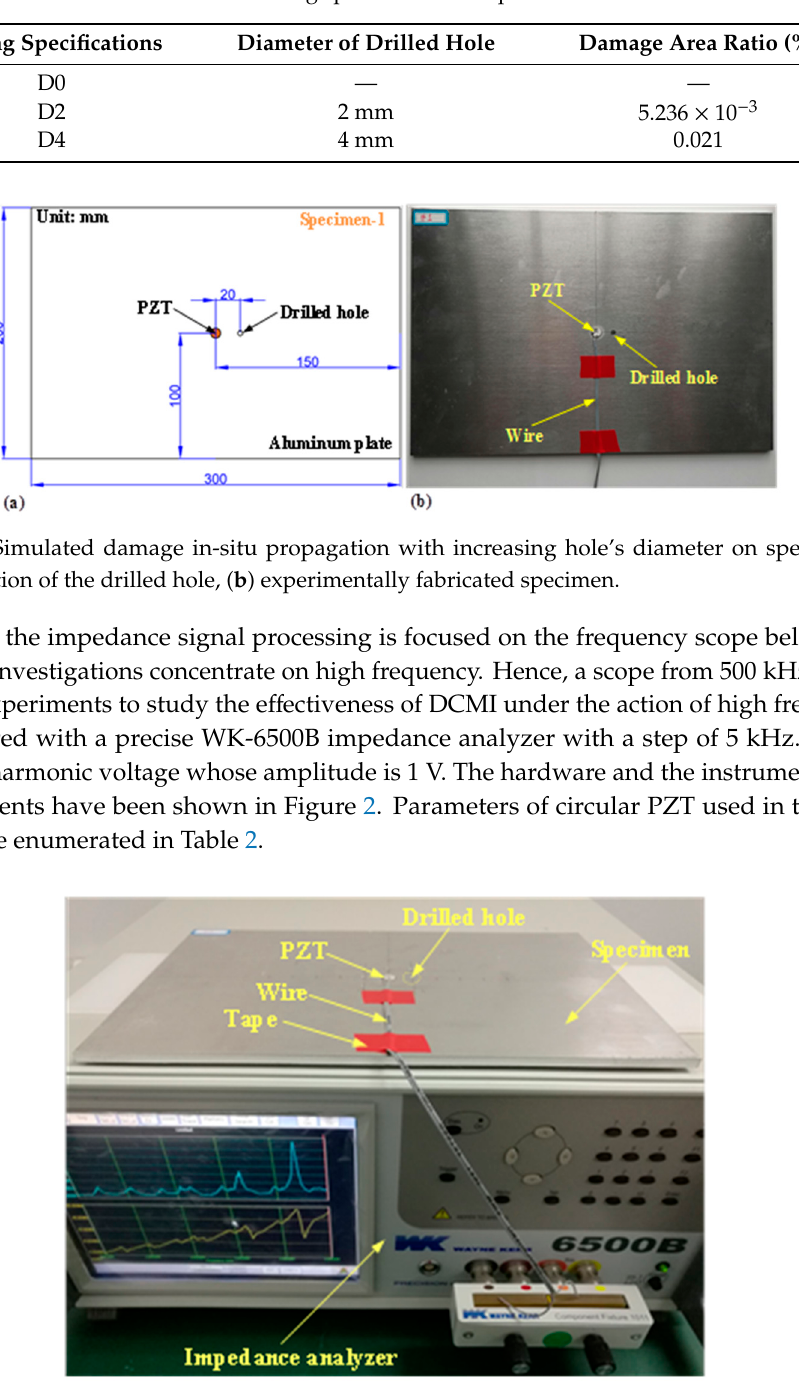
Figure 2. Testing platform used in experiments. Table 2. Typical parameters of circular piezoelectric sensors (PZT).